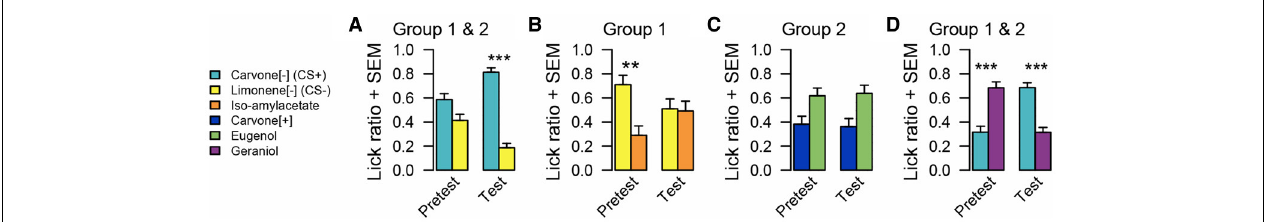
FIGURE 4 | Odor preference measured by lick ratio in experiment 3. (A) For all animals, there is no preference between C[ − ] and L[ − ] before conditioning. After conditioning, animals preferred C[ − ]. (B) Animals of group 1 preferred L[ − ] over I before conditioning. After conditioning, this spontaneous preference disappeared. (C) There is no preference for animals of group 2 between C[ + ] and E before and after conditioning.